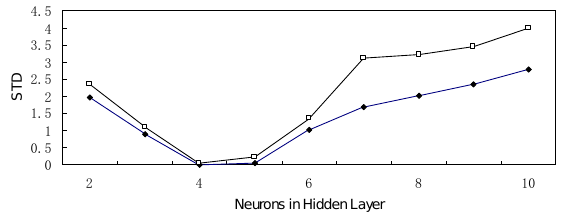
Fig. 3.1 SDT versus number of neurons in the hidden layer for: (  ) during the training, and (  ) during the